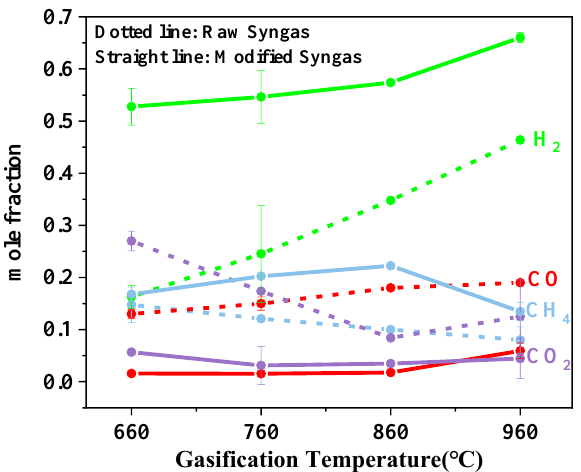
Figure 7. Effect of gasification temperature on the gas distribution.